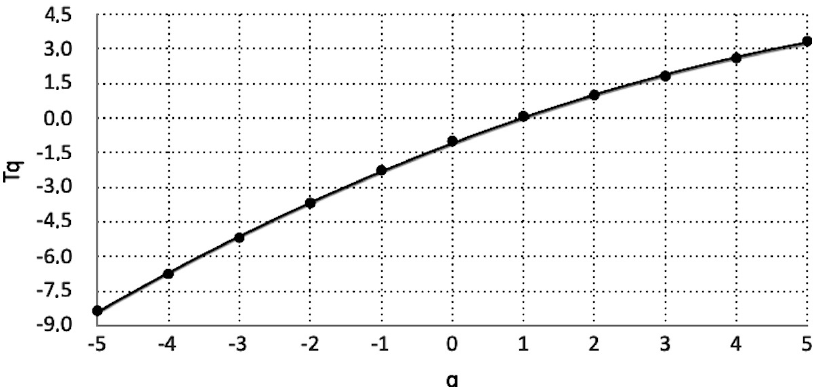
Figure 3. Classical scaling exponent τ ( q ) with q for the AGP monitoring station and date 28 July 2007 (case i/i = 3 of Table